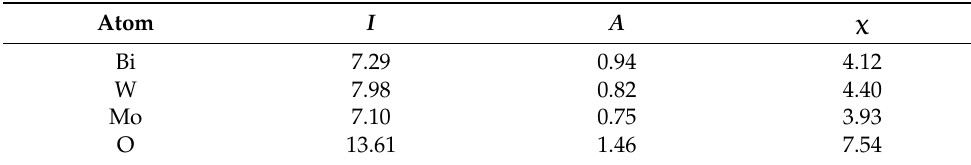
Table 4. The ionization potential ( I ), electron affinity ( A ), and absolute electronegativity ( χ ) of the Bi, W, Mo, and O atoms in the unit of “eV”.